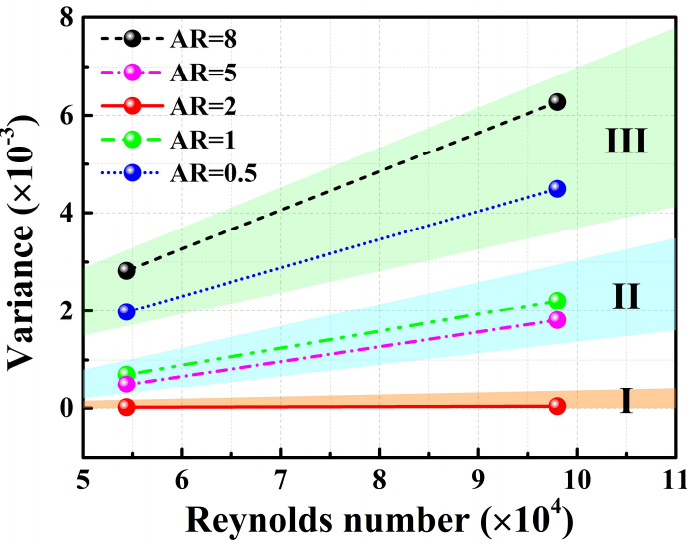
Figure 22. Variance of dimensionless vertical velocity fluctuations at the intersection point of groove centerline and horizontal line.